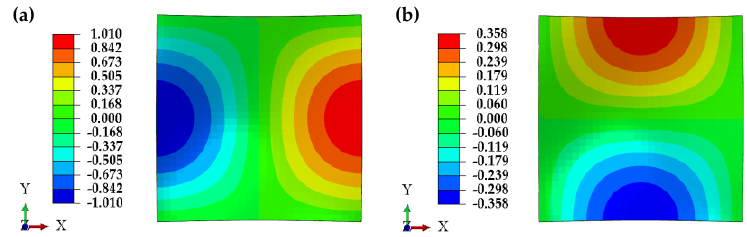
Figure 4. Interlaminar shear stress distributions at the [90/0] interface of a [0/90/0] laminate ( a = 3 mm, S = 4), obtained from a linear elastic traction-separation description interface: ( a ) τ xz ; ( b ) τ yz .